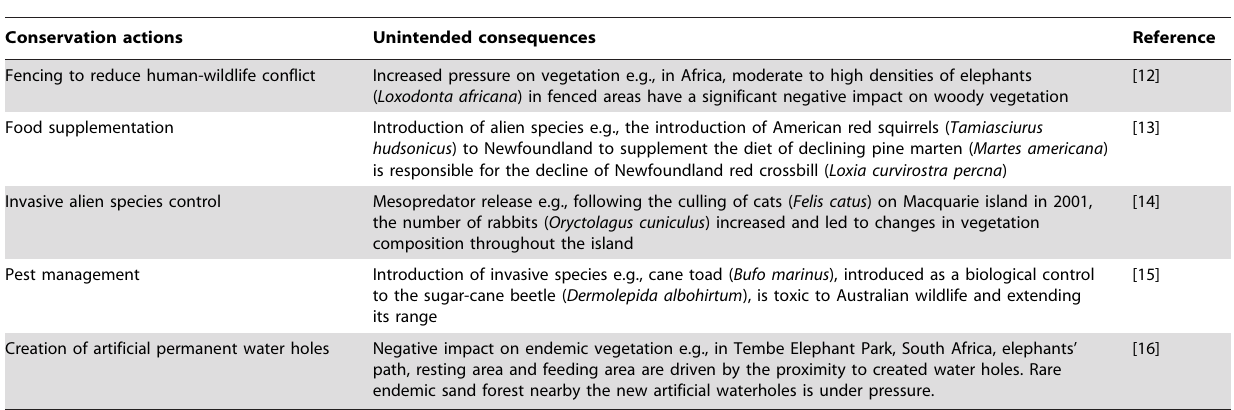
Table 1. Examples of conservation actions that have had unintended negative impact on non-target species.